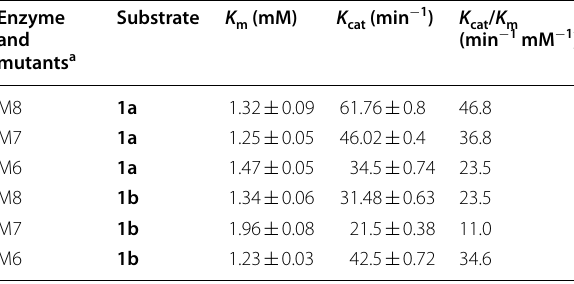
Table 3 Kinetic characterization of the Ec MAL variants M6–M8 to substrates 1a and